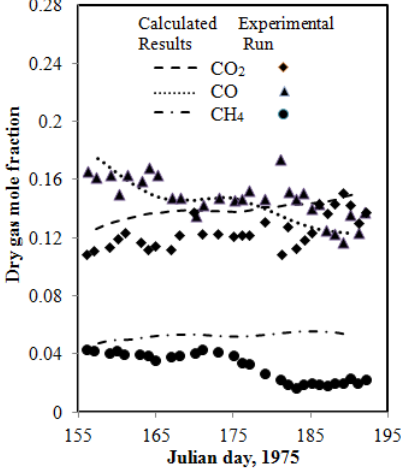
Figure 16. Comparison of calculated exhaust gas compositions from Gunn and Whitman [45] with experimental results from the Hanna field trial.